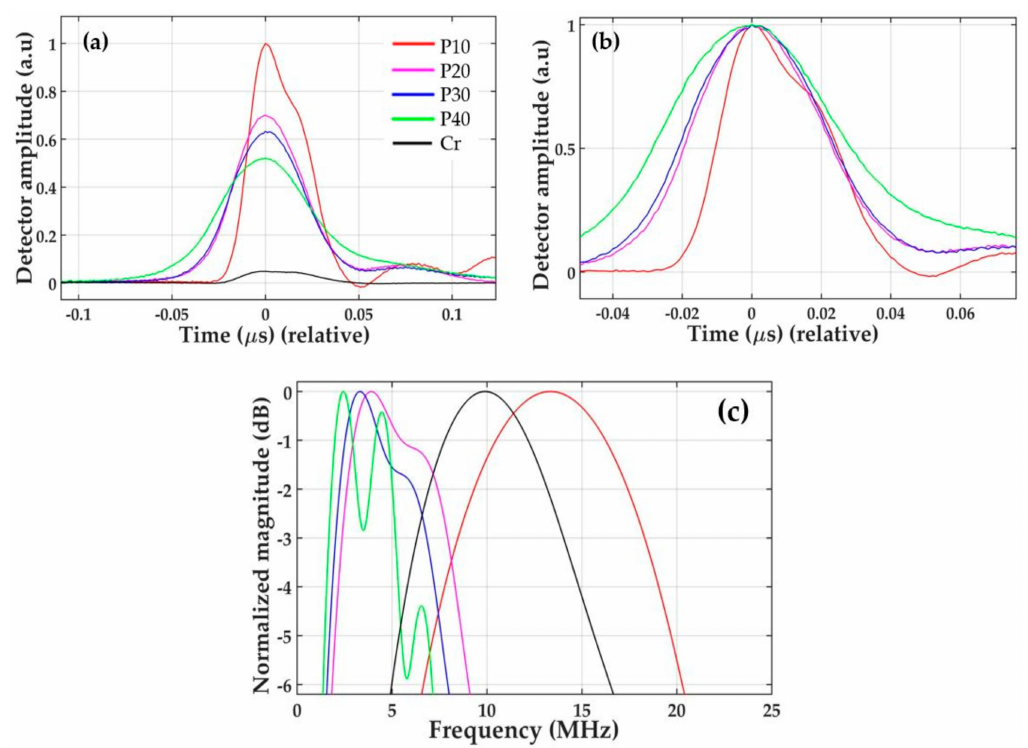
Figure 5. ( a ) Time-domain waveforms generated by the transmitters; ( b ) Comparison of normalized temporal pulse widths for the waveforms obtained in ( a ); ( c ) Frequency spectra obtained from the time-domain waveforms in ( a ).